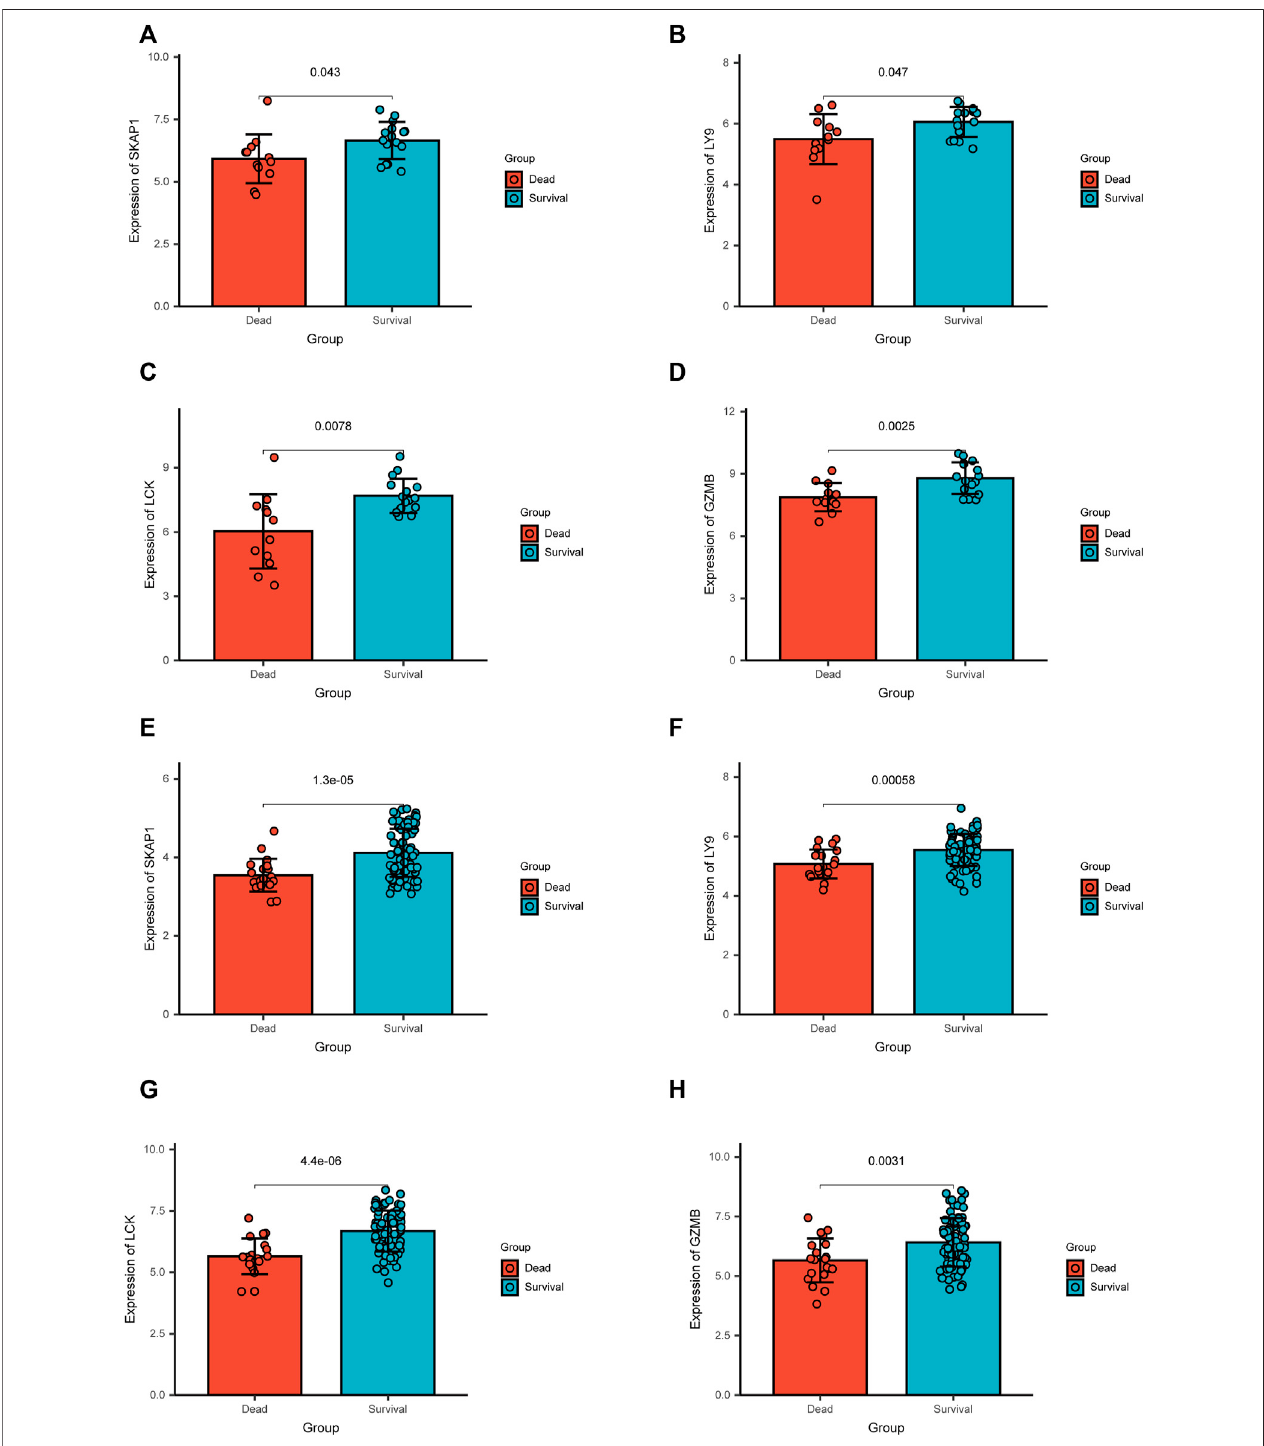
FIGURE 9 | Results of the differential expression analysis of the microarray data in two independent cohorts. (A – D) In GSE19743, key genes, SKAP1, LY9, LCK, and GZMB, were up-regulated in survival patients. (E – H) In GSE77791, key genes, SKAP1, LY9, LCK, and GZMB, were up-regulated in survival patients.